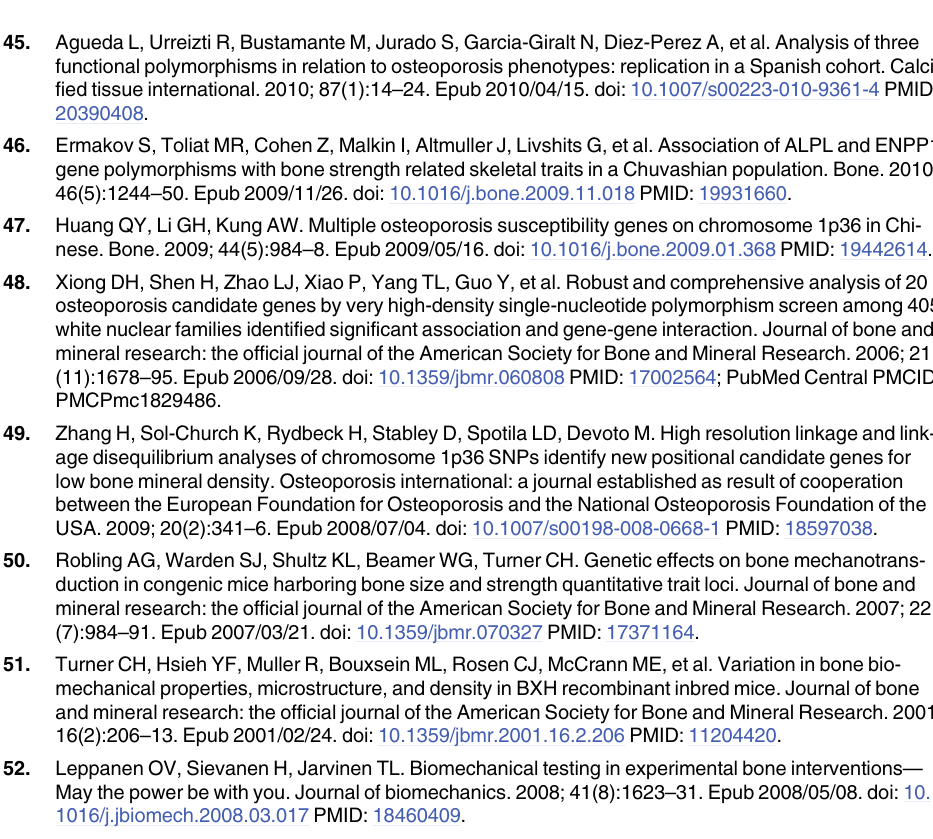
PLOS ONE | DOI:10.1371/journal.pone.0148571 February 5,